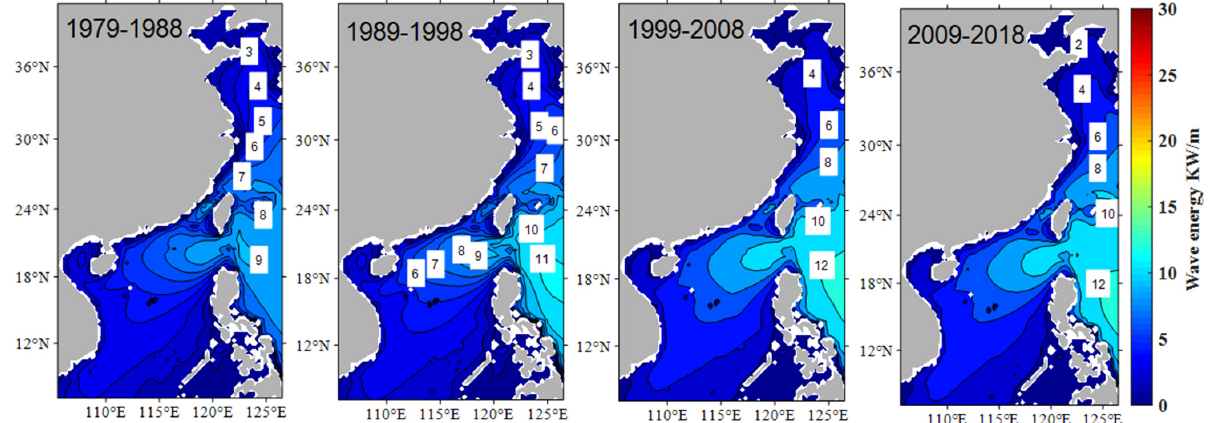
Figure 6. The decade distribution of wave energy density ( P w ) in spring.